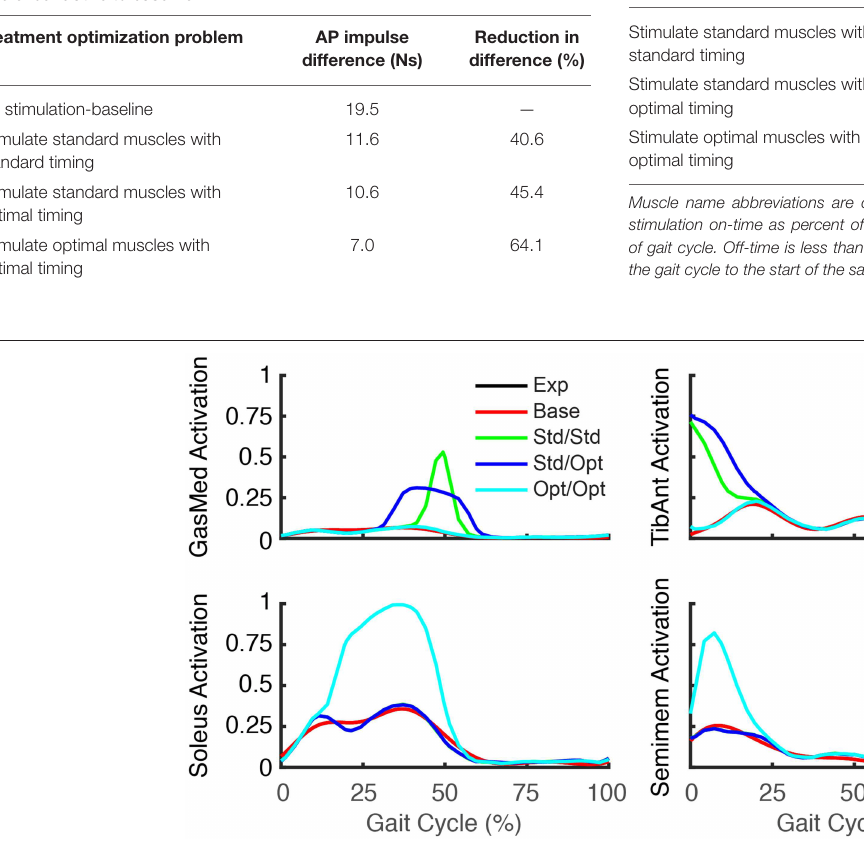
Frontiers in Neurorobotics |